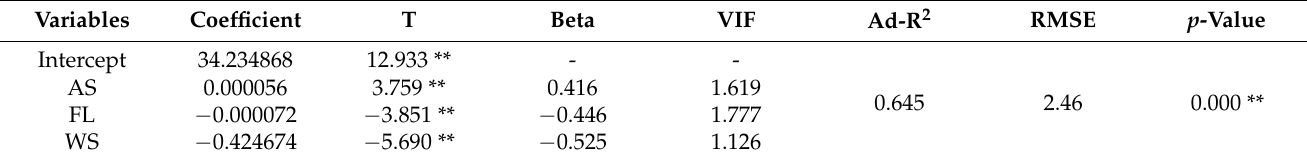
Table 2. Multiple stepwise linear regression model